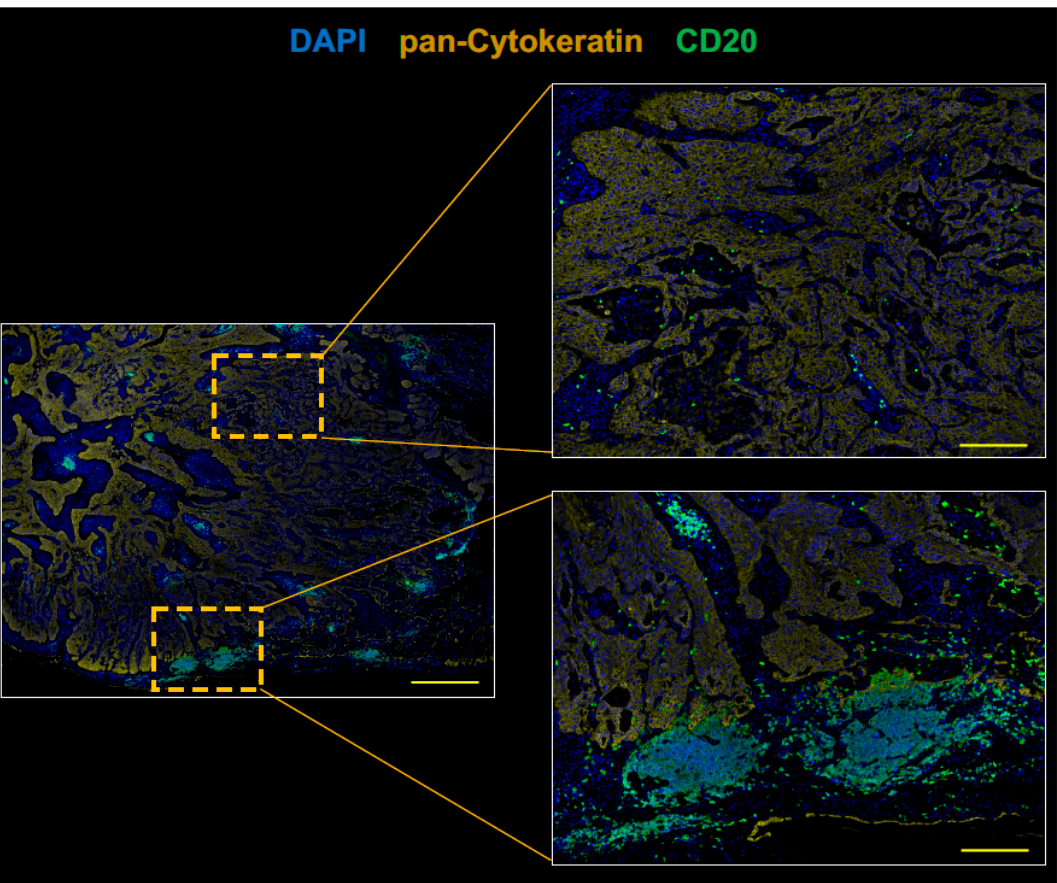
Figure 3. CD20+ B cells infiltrate pretreatment lung tumor at the invasive tumor margin. Serial FFPE sections were stained with antibodies against CD20 (green) and pan-Cytokeratin, and analyzed by fluorescent multiplex immunohistochemistry. The right panels show the boxed regions in the left panel at high magnification. CD20+ B cells (green) were infiltrated at the invasive tumor margin rather than tumor cell nests. Scale bars, 1000 μ m (left panel), or 200 μ m (right panels) are shown in each panel.